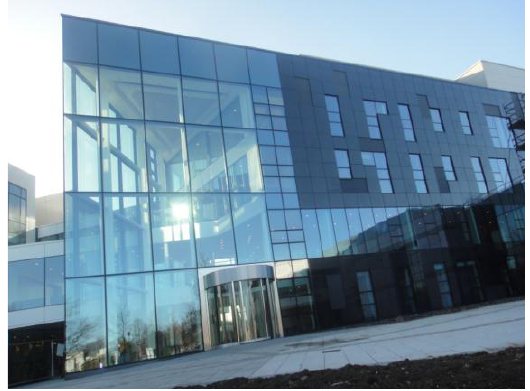
Fig. 1. Completed Charles